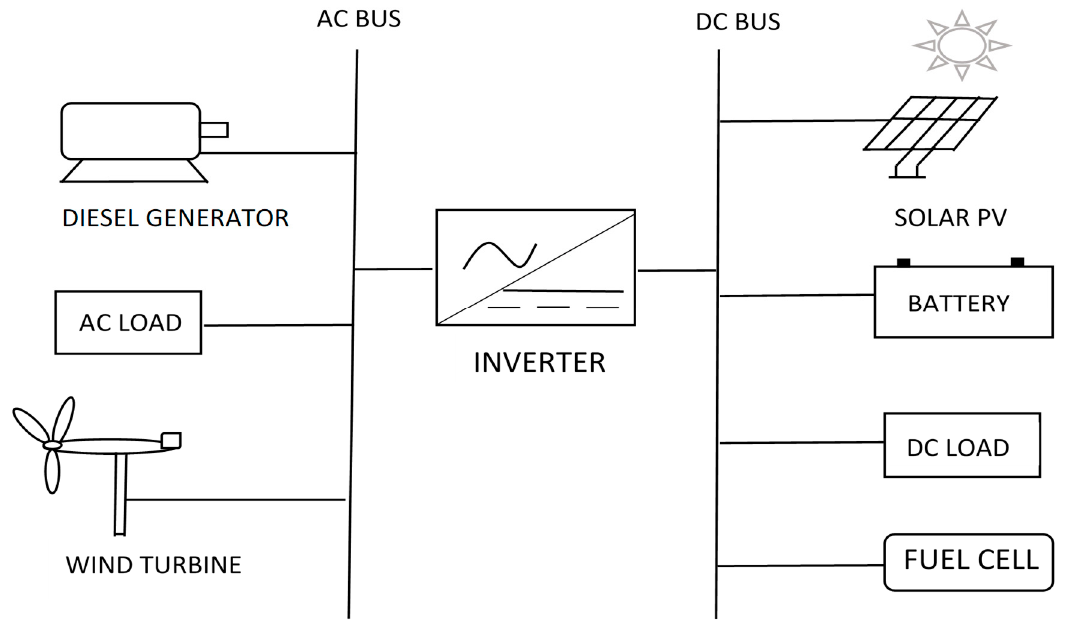
Figure 1. A hybrid isolated microgrid scheme.